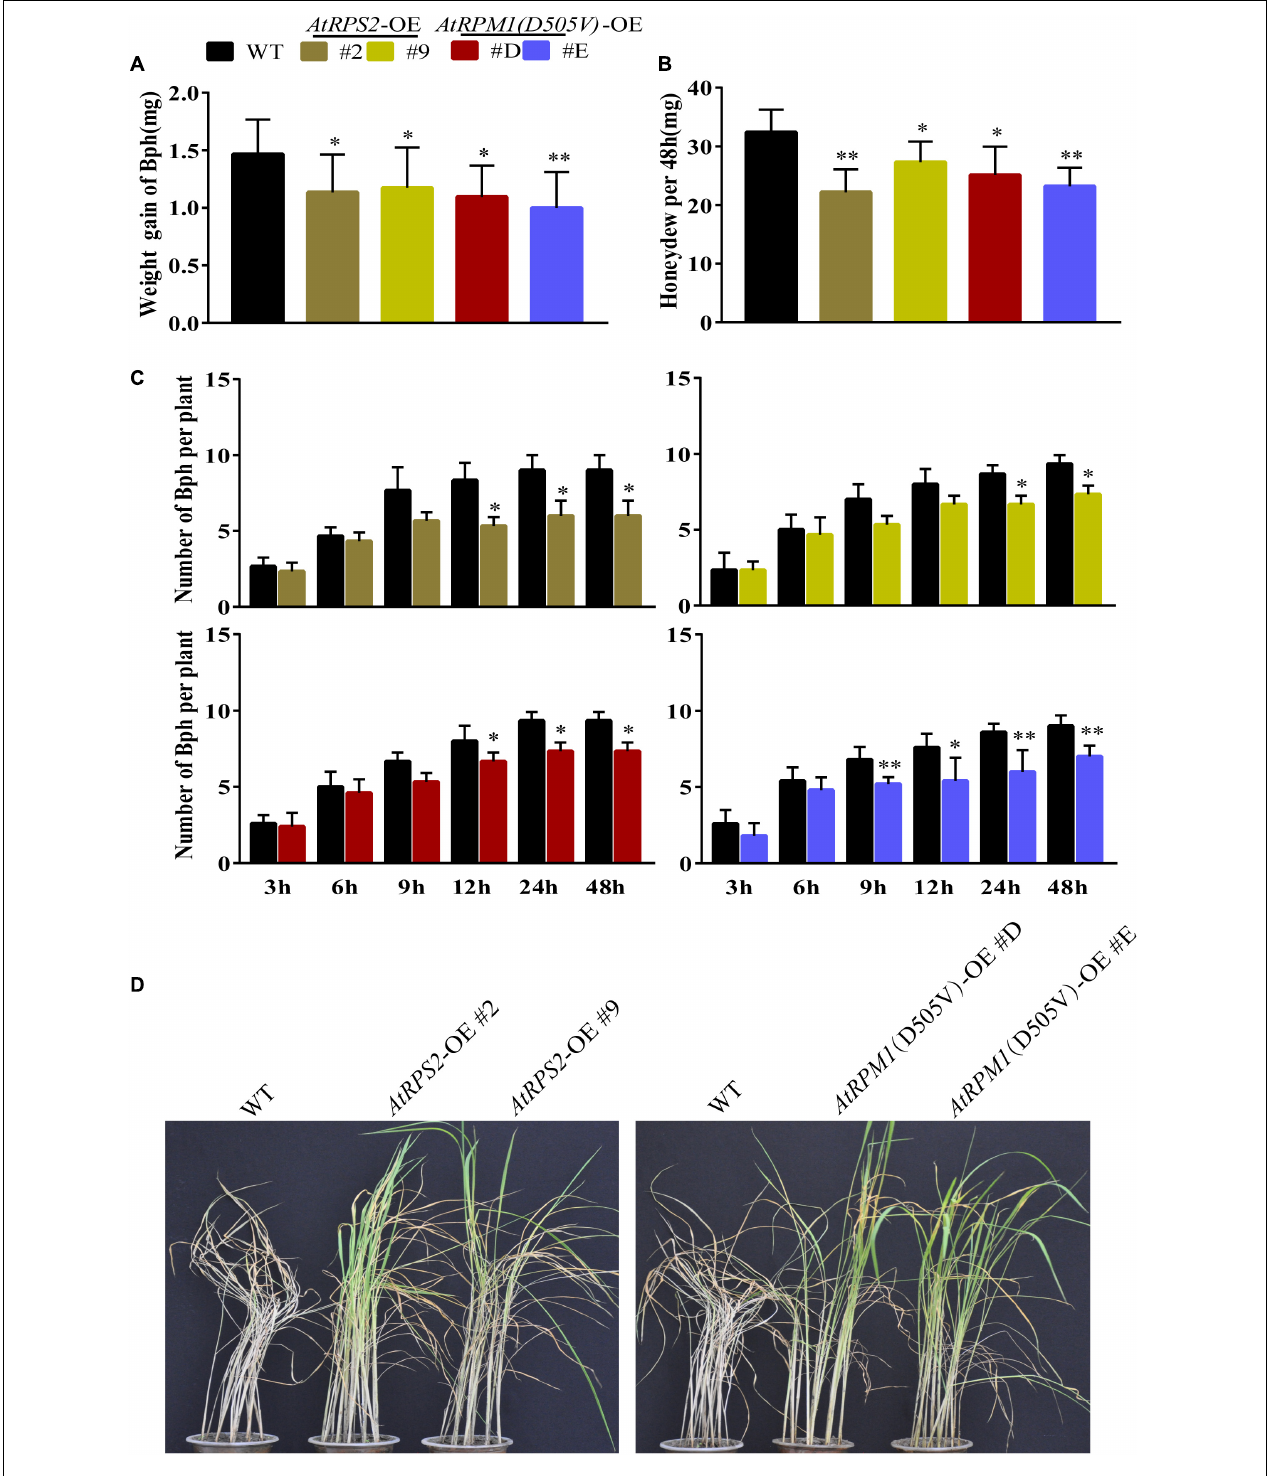
FIGURE 8 | AtRPS2 and AtRPM1 ( D505V ) Confer Resistance to BPH in Transgenic Plants. (A,B) Weight gain and Honeydew excretion of BPH on transgenic plants and Nipponbare after feeding 2 days. Data were shown as means ± SD ( n = 20). (C) Host choice test of BPH on transgenic plants and Nipponbare plants. Data are shown as means ± SD ( n = 10). Asterisks denote significant differences (one way ANOVA, ∗ P < 0.05, ∗∗ P < 0.01). Similar results were obtained in three independent experiments. (D) Representative images of the transgenic plants and Nipponbare plants after BPH infestation. Note that the Nipponbare seedlings were dead thoroughly, but the transgenic plants still